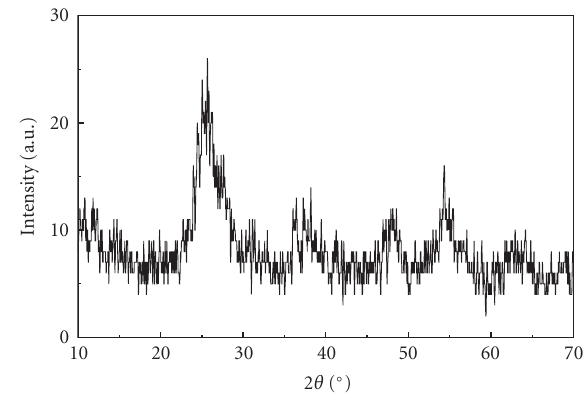
Figure 4: XRD pattern of TiO 2